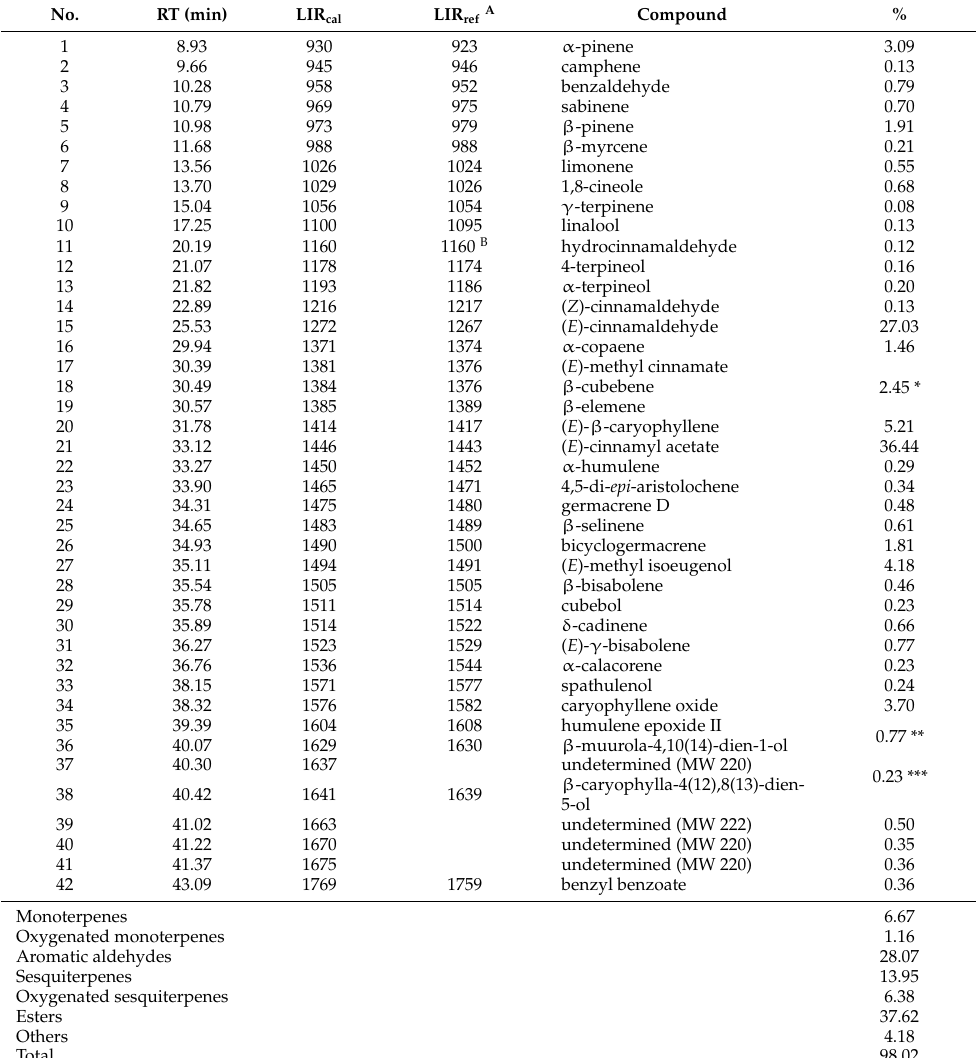
Table 4. O. quixos leaf essential oil